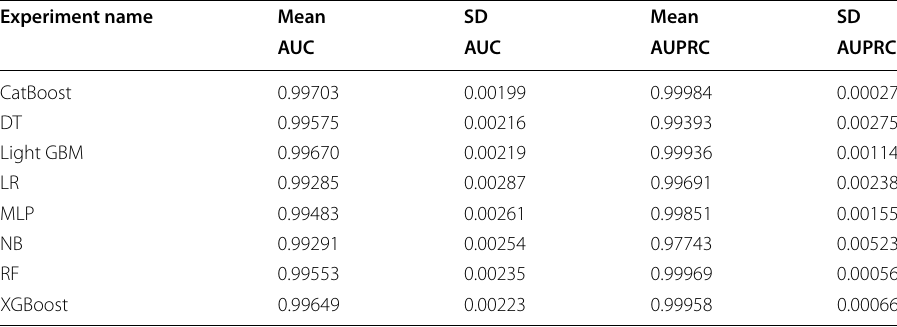
Table 2 Classification results for the information theft dataset no sampling default hyperparameter values experiments; mean and standard deviations of AUC and AUPRC, (10 iterations of 5-fold